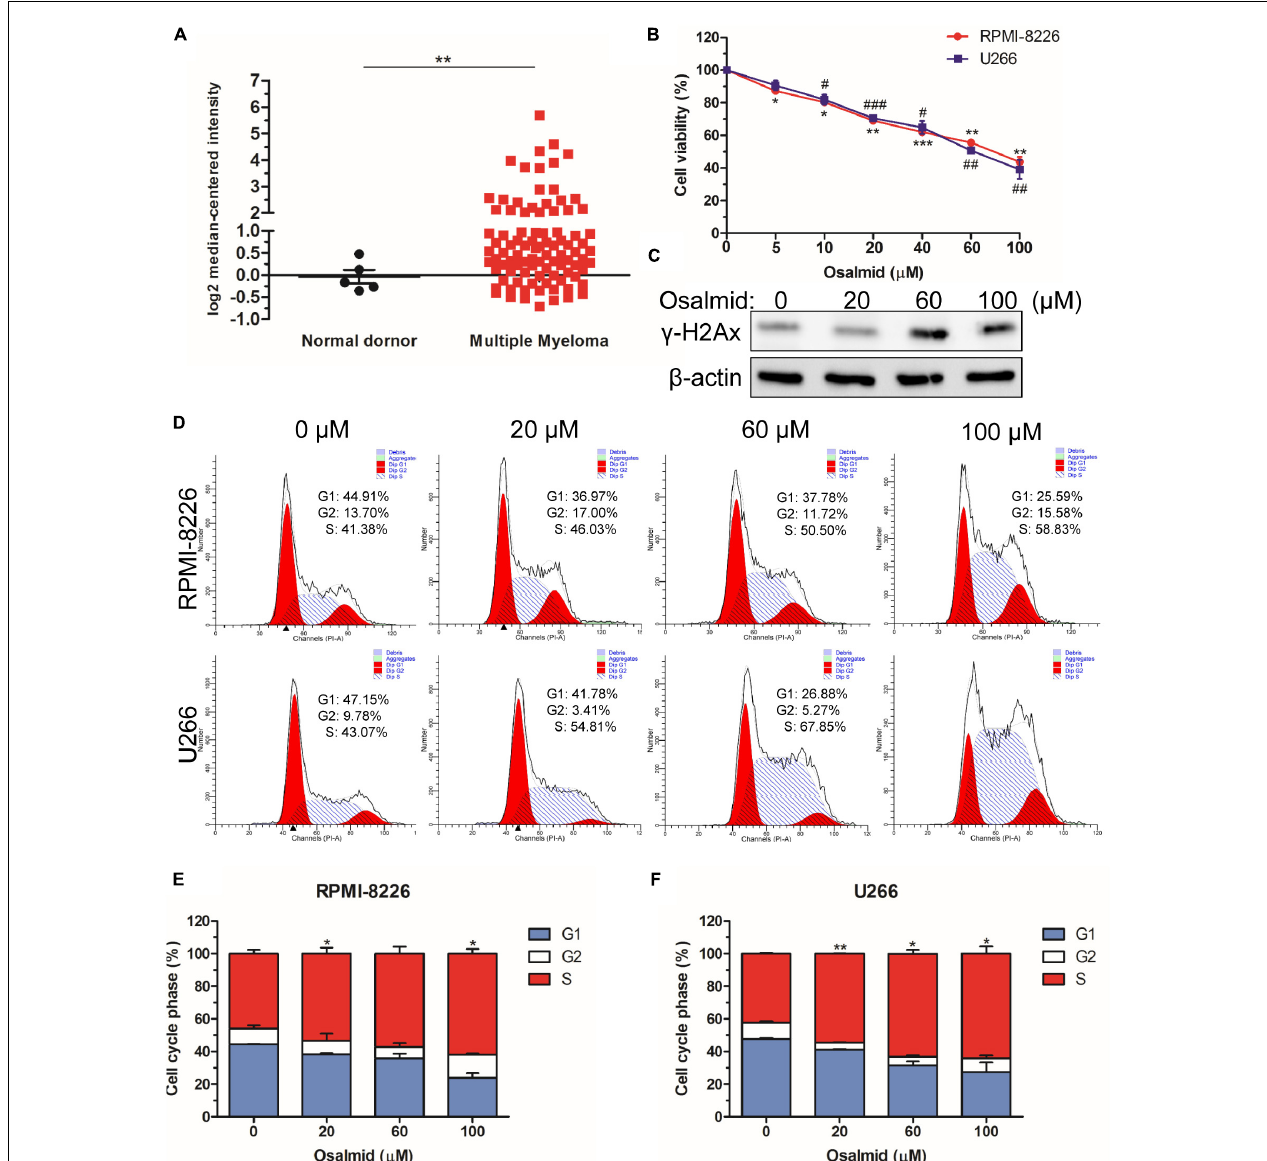
FIGURE 7 | RRM2 inhibitor osalmid showed antitumor activity. (A) The mRNA expression level of RRM2 between MM patients and normal donors using the Oncomine database. (B) CCK8 assay demonstrated an inhibition of RPMI-8226 and U266 cell proliferation following osalmid treatment. (C) Western blot assay of γ H2Ax protein expression in U266 cells treated with different doses of osalmid. (D) Flow cytometry assay analyzed RPMI-8226 and U266 cell cycle distribution treated by osalmid. (E,F) Statistical analysis of cell accumulation of cells in S phase in RPMI-8226 and U266 cells following treatment with osalmid. Error bars indicate mean ± SD. # , * p < 0.05, ## , ** p < 0.01, ### , *** p <